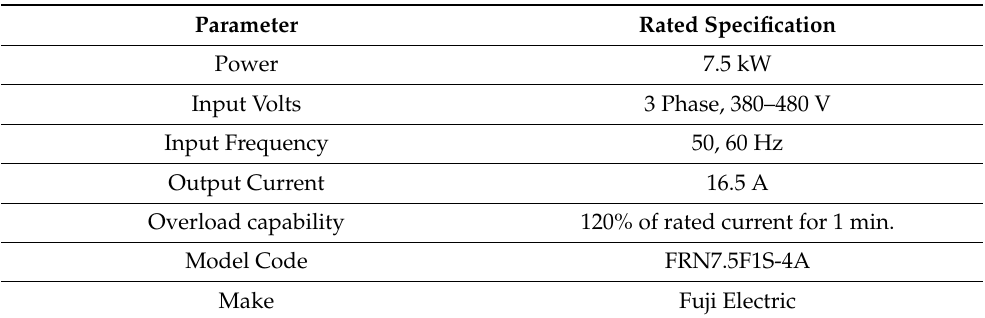
Table 2. Technical specifications of hydraulic pump motor